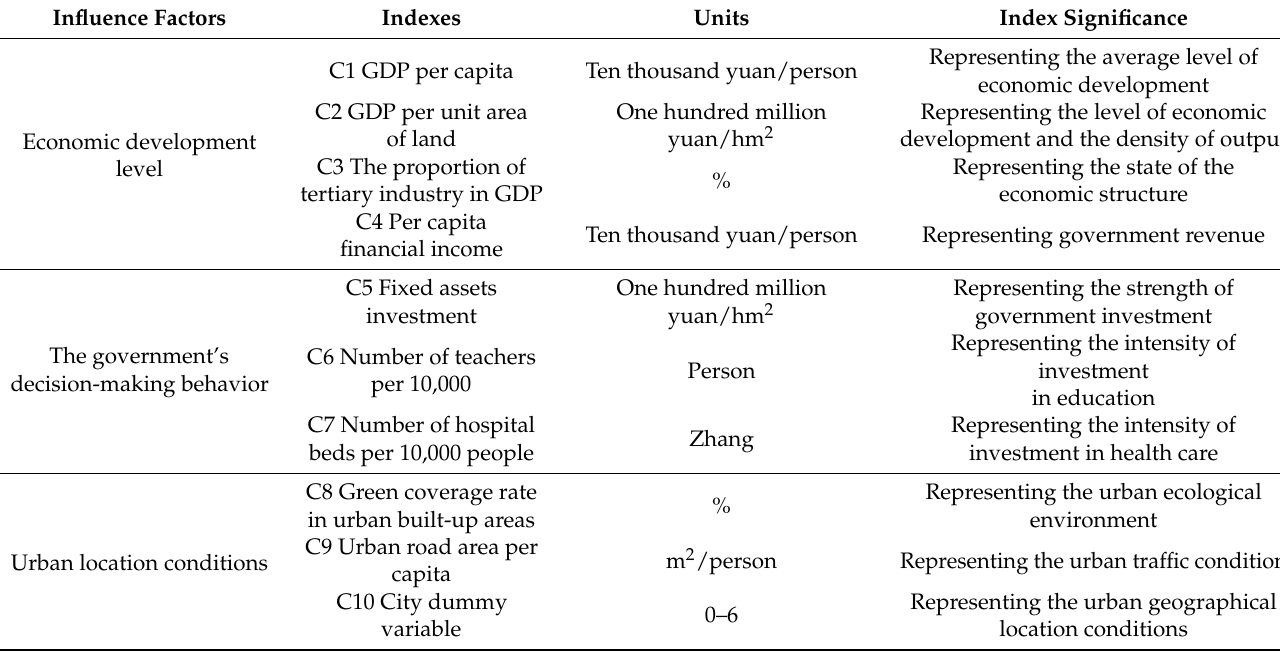
Table 3. Explanatory